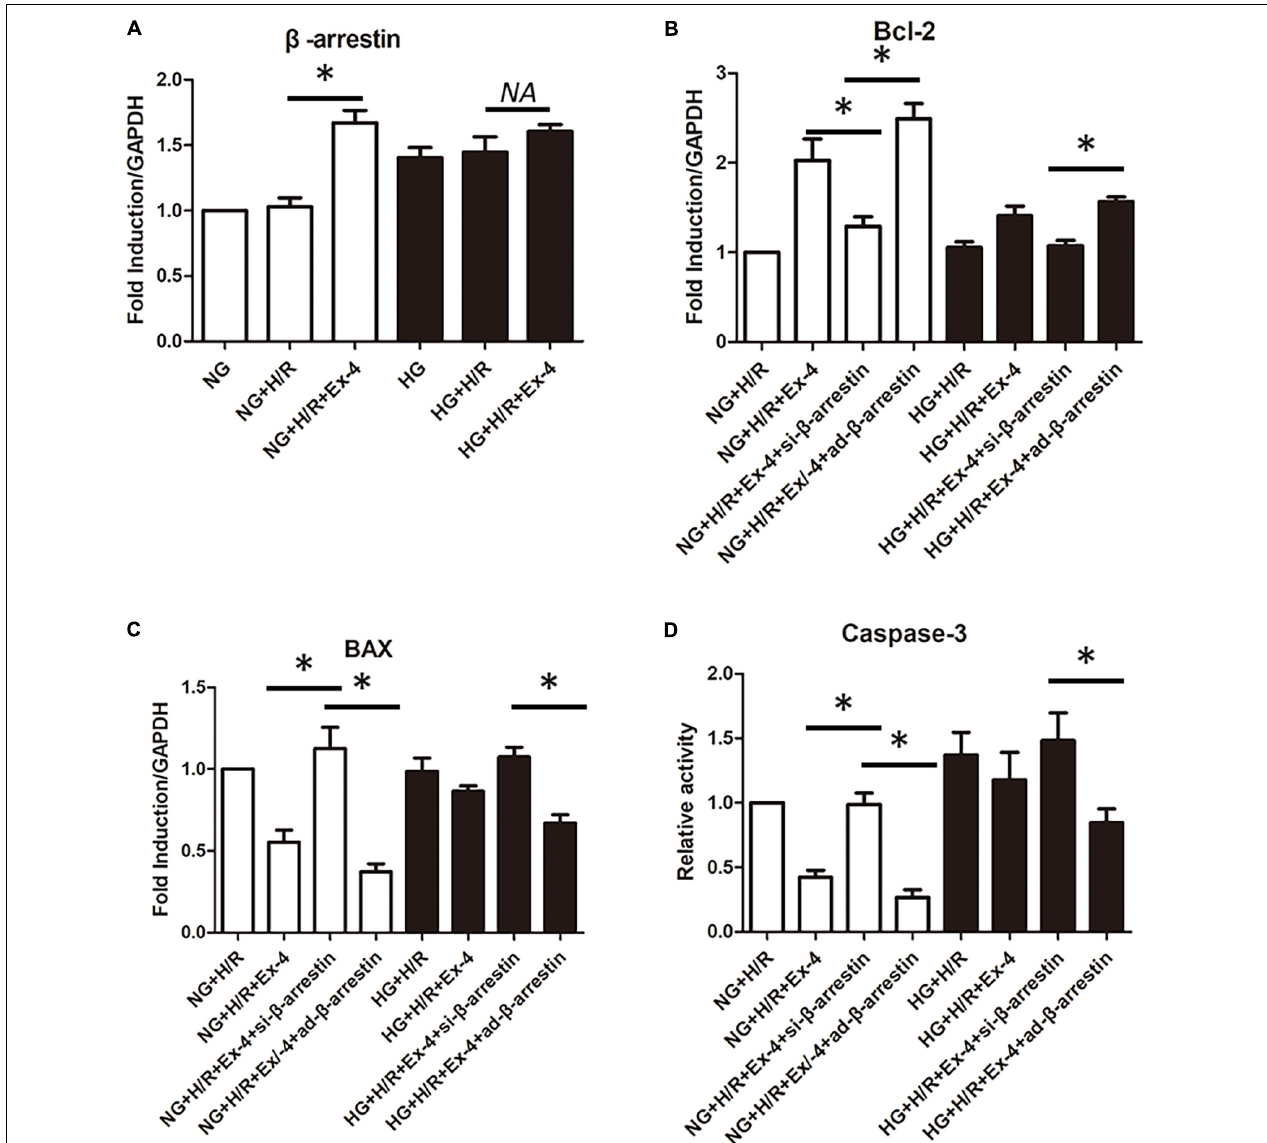
FIGURE 3 | β -arrestin overexpression restored cardioprotective effects of GLP-1 in high glucose cultured H9C2 cells. (A) qRT-PCR measurement of β -arrestin transcription. (B–D) Exploring the changes in cardioprotective effects of Exendin-4 while utilizing β -arrestin siRNA and adenovirus transfection. *P <